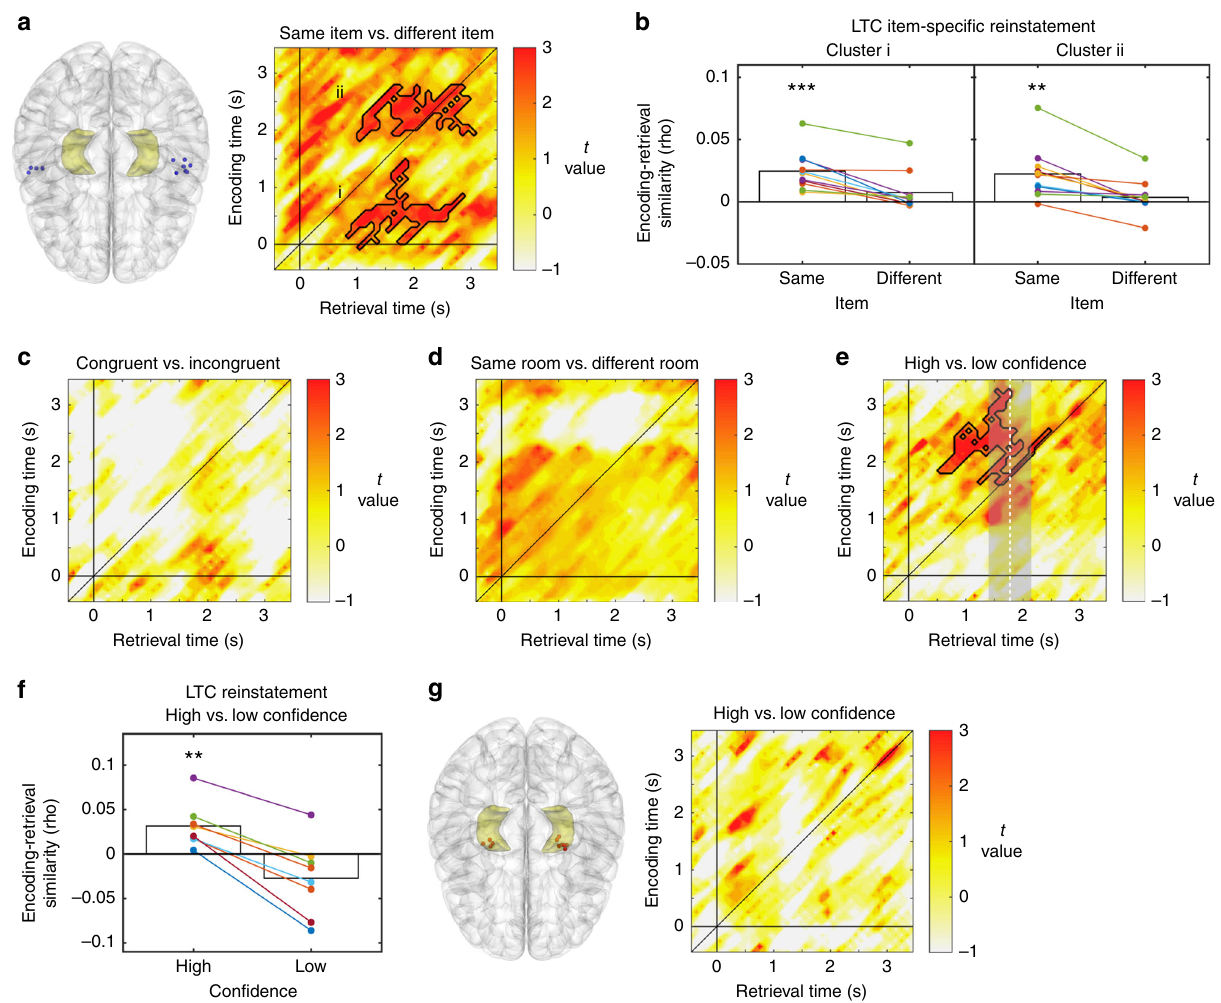
Fig. 3 Reinstatement of item-speci fi c information in the lateral temporal cortex. a T -map contrasting encoding-retrieval similarity for same items versus different items. Areas of signi fi cant correlations are outlined in black. b Mean reinstatement in these clusters for “ same item ” and “ different item ” trials. c and d T -maps for congruent vs. incongruent and same vs. different contexts (rooms) contrasts. e Encoding-retrieval similarity in the “ same item ” condition split into high and low con fi dence trials; T -map revealed a signi fi cant cluster. Dashed line and shaded grey area shows mean response time ± S.E. M across the group of patients. f Reinstatement for high and low con fi dence trials in the cluster observed in e , tested against zero. g Absence of signi fi cant con fi dence effects in the hippocampus. *** and ** in panels b and f indicate rho-values that are across the group signi fi cantly different from 0 at p < 0.01 and p < 0.001